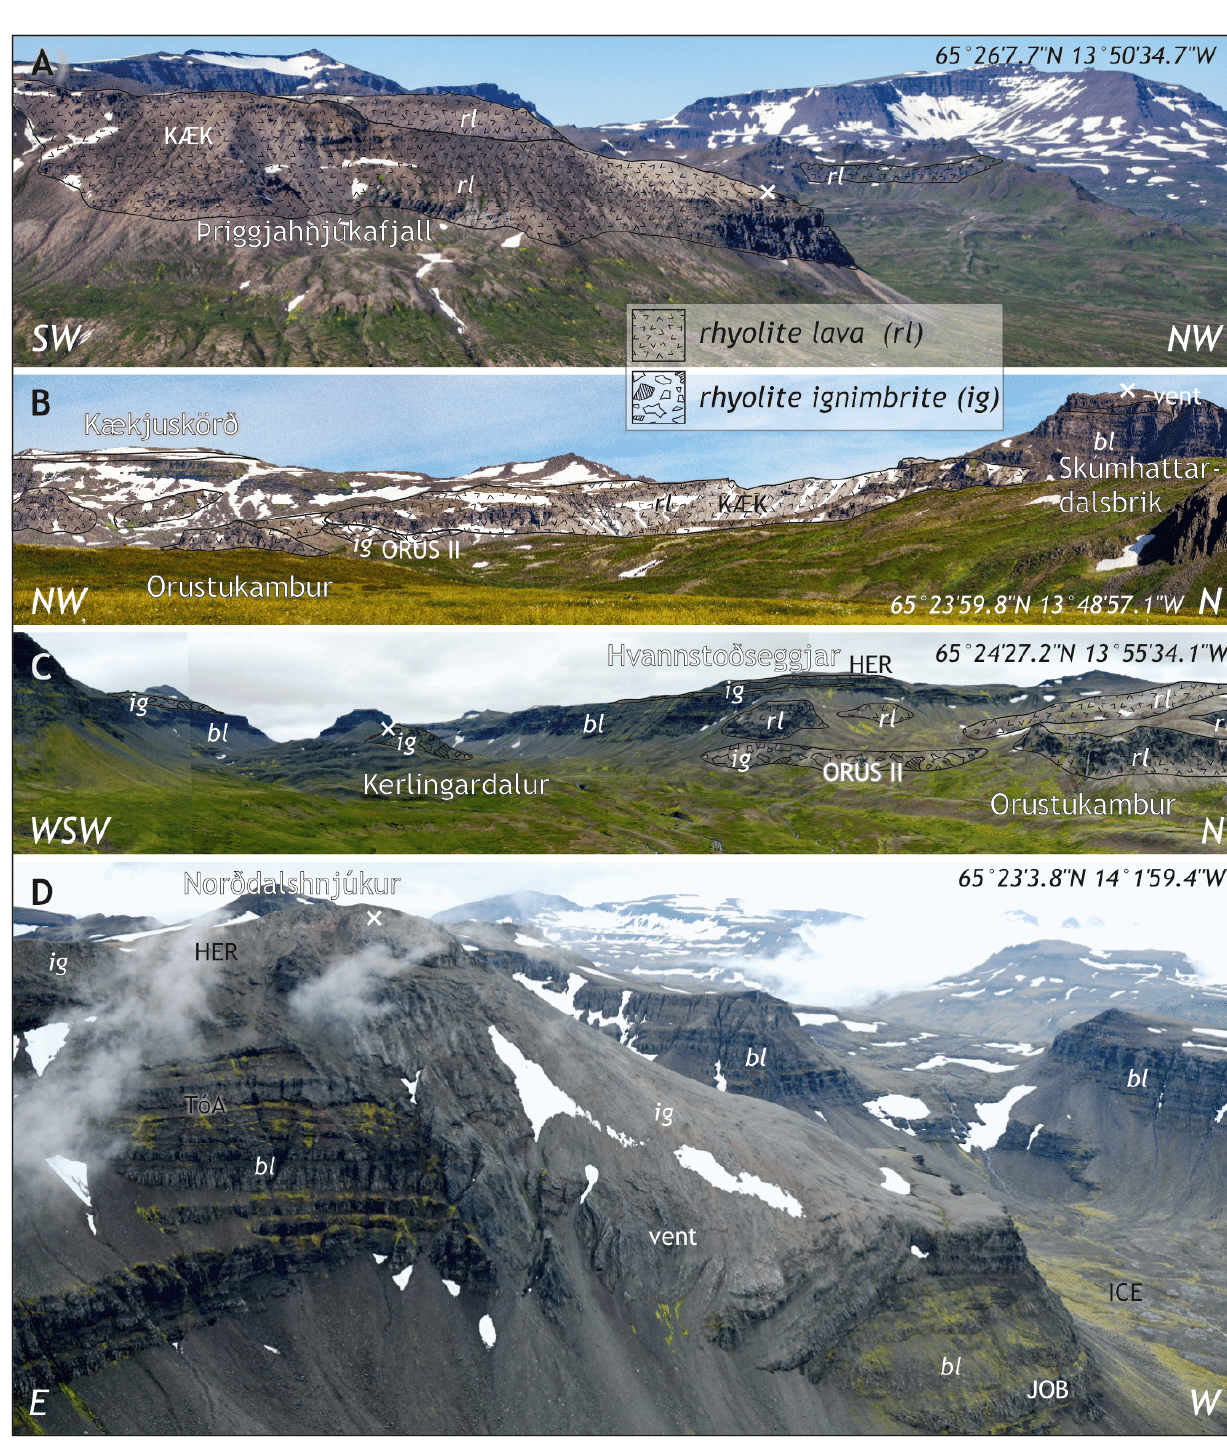
Figure 10: Annotated field photographs illustrating the geology of the area in Figure 9. Abbreviations: b = basalt, r = rhyolite, hy = hyaloclastite, l = lava, i = intrusion, ig = ignimbrite. × marks the location of the coordinates men- tioned in each photograph. For names of stratigraphic formations, see text and Figure 13. [A] the Þriggjahnjúkaf- jall rhyolites I and II were erupted north of Skúmhattardalsbrik and flowed northward. [B] Panoramic view of the rhyolite lavas and ignimbrites around Orustukambur. Also note the feeder dyke and lava flow of dacite in Skúmhat- tardalsbrik. [C] Continuation of the panoramic view in [B], looking into Kerlingardalur. [D] Unmanned Aerial vehicle (drone) photograph of a large vent structure in Norðdalshnjúkur that is connected to the Herfell